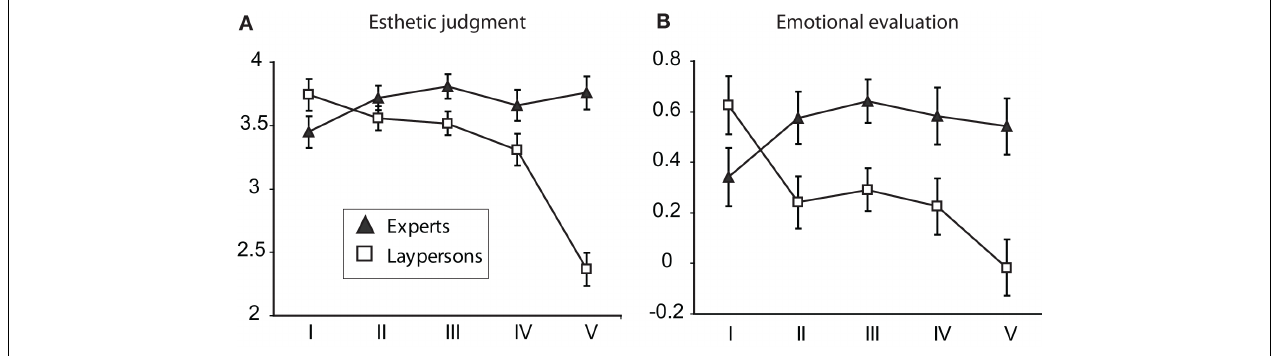
FIGURE 1 | Mean esthetic judgments (A) and emotional ratings (B) of the paintings in Part 2 decrease from representational (I) toward the abstract (V) category in laypersons but not in experts. The error bars represent